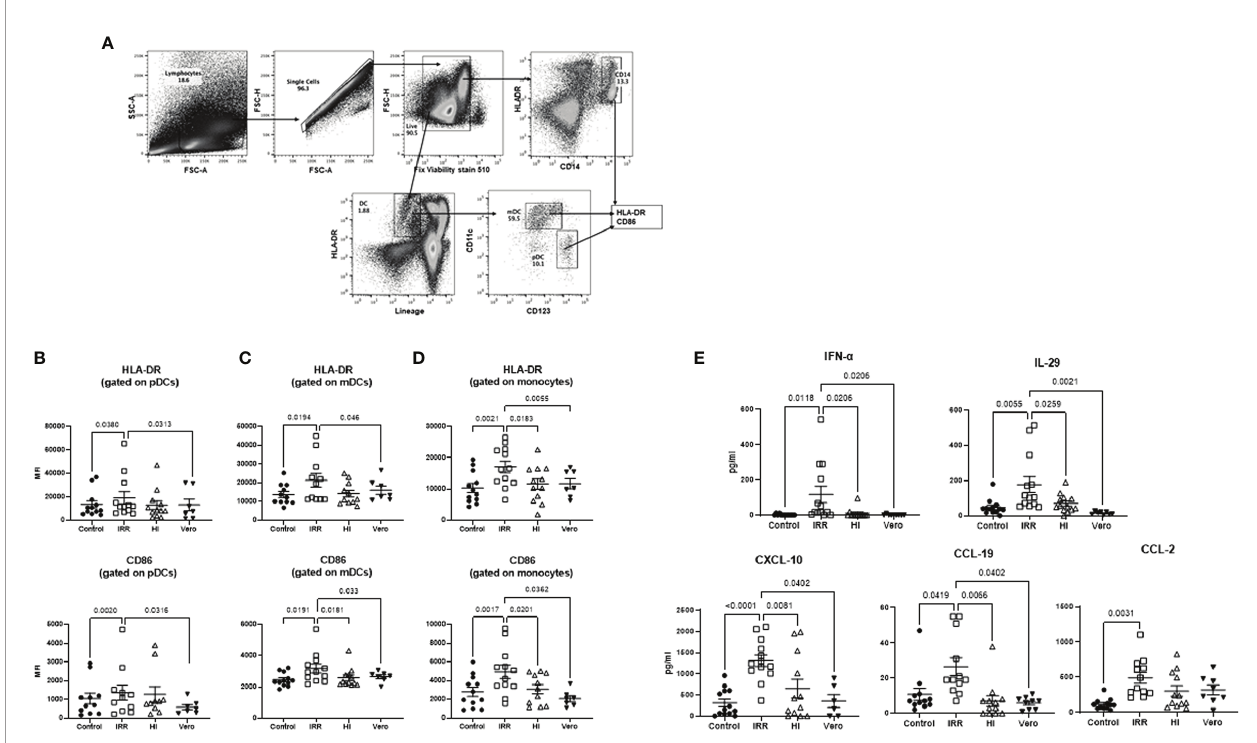
FIGURE 1 | Irradiated severe acute respiratory syndrome coronavirus 2 (SARS-CoV-2) is a better activator of monocytes and DCs than heat inactivated SARS-CoV-2. PBMCs were stimulated o/n with irradiated (IRR) or heat-inactivated (HI) SARS-CoV-2 or Vero cell lysate (Vero). Flow cytometry was used to determine the upregulation of surface markers. Plasmacytoid dendritic cells (pDCs), myeloid dendritic cells (mDCs), and monocytes (mono control) are the unstimulated population gated on pDCs, mDCs, and monocytes. IRR, HI, and Vero are stimulated conditions from the same donors. (A) Gating strategy for pDCs, mDCs, and mono (monocytes); MFI of expression of activation markers HLA-DR and CD86 on (B) gated pDCs (lineage − HLADR + CD123 + ); (C) gated mDCs (lineage − HLADR + CD11c + ); (D) gated CD14 + monocytes using fl ow cytometry. (E) Graphs depict the quantitation of cytokines/chemokines in the supernatant by multiplex. Mean ± SE. N = 12 subjects. p -value was calculated using one-way ANOVA followed by Tukey ’ s